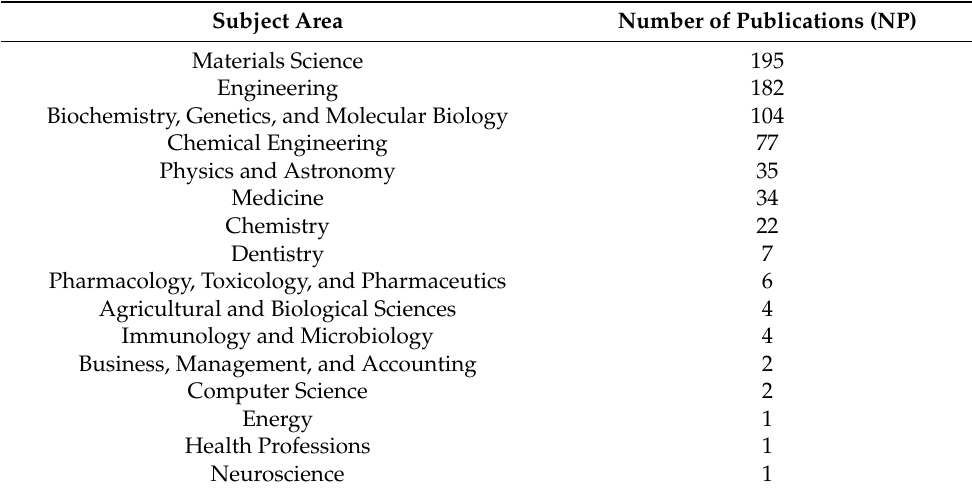
Table 2. Subject areas found in query A.